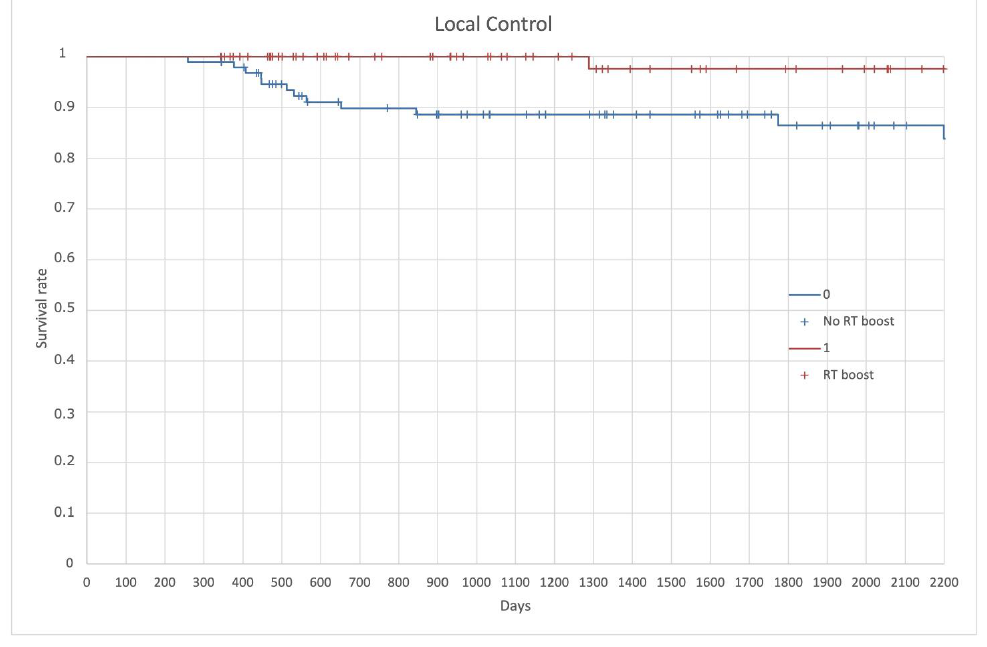
Figure 6. Metastasis Free Survival (MFS).